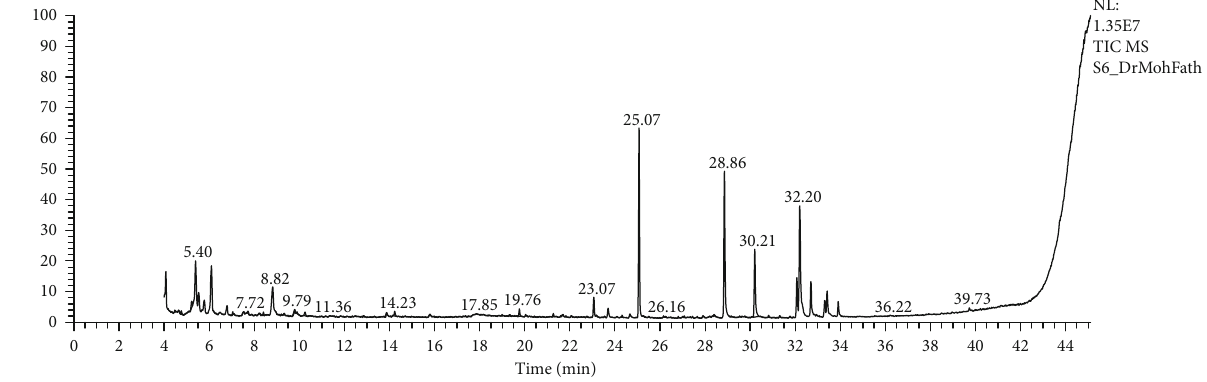
Figure 1: GC-MS chromatogram of aqueous plant extract of Zingiber o ffi cinale